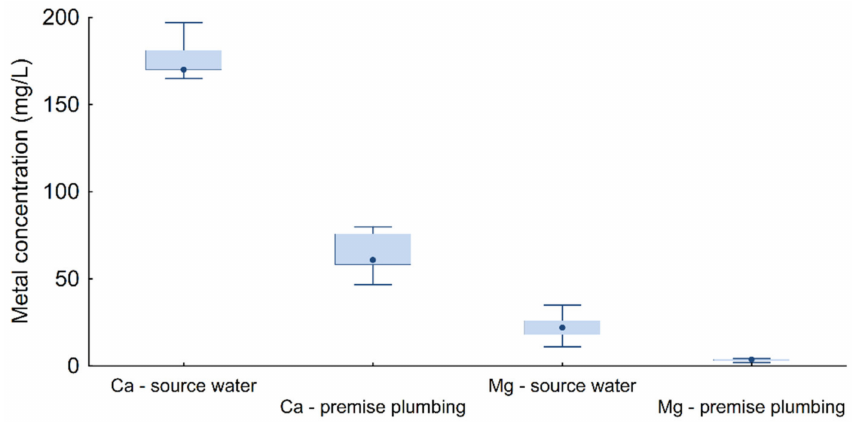
Figure 3. Metal concentration (Ca and Mg) in Jadro source water and premise plumbing. The results also show that the WDS is more contaminated with Legionella in hotels that are open seasonally than in hotels that are open year-round (Figure 4) as well as in older hotels.